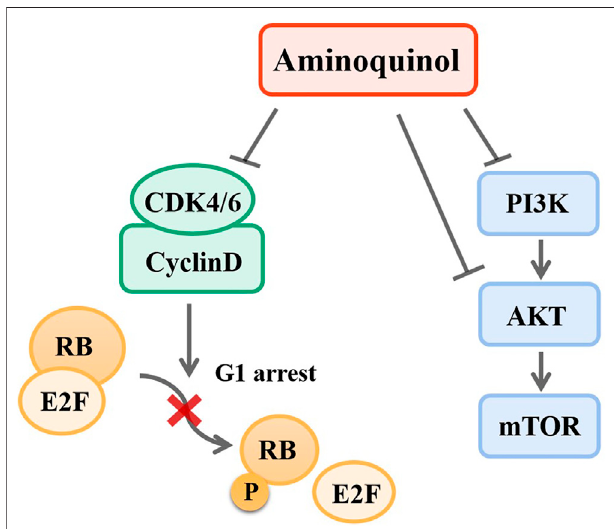
FIGURE 8| Mechanisms ofaminoquinol. Aminoquinol inhibited CDK4/6 phosphorylation and the complex with cyclinD, blocked the phosphorylation of RB and the releases of pRB via its association with transcription factor E2F, andsubsequentlyinhibitedthecellcycletoproceedfromG1toS-phase. In addition, aminoquinol also suppressed the signal pathway PI3K/AKT/ mTOR, therefore inhibited cell proliferation and promoted apoptosis.